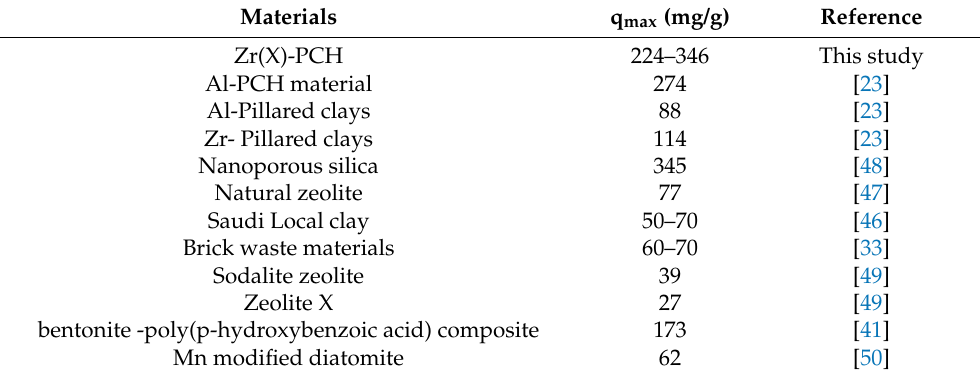
Table 5. Basic blue-41. Adsorption properties of some selected aluminosilicate